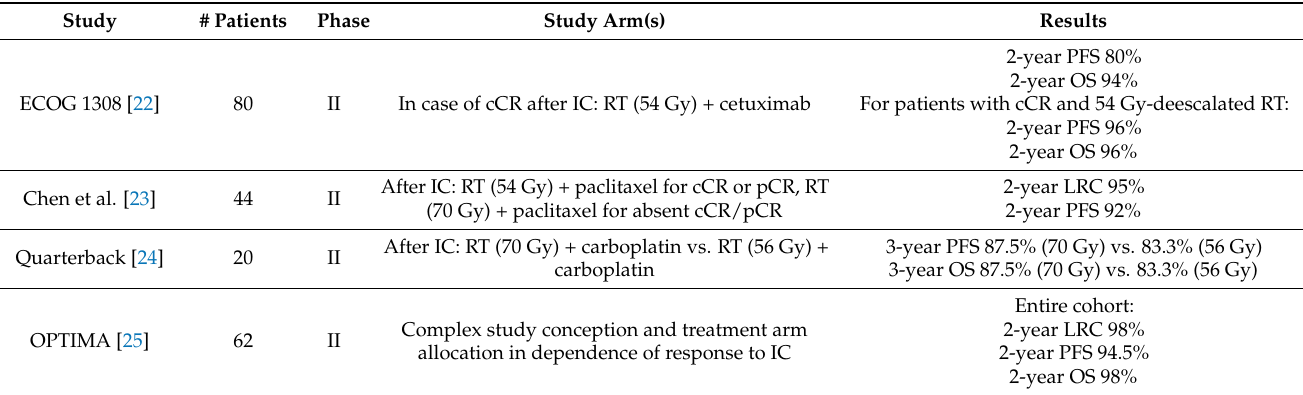
Table 2. Summary of important (chemo) radiotherapy de-escalation trials in which induction chemotherapy was applied. RT = radiotherapy, OS = overall survival, PFS = progression-free survival, LRC = local/locoregional control, IC = induction chemotherapy, cCR = complete clinical remission, pCR = partial clinical